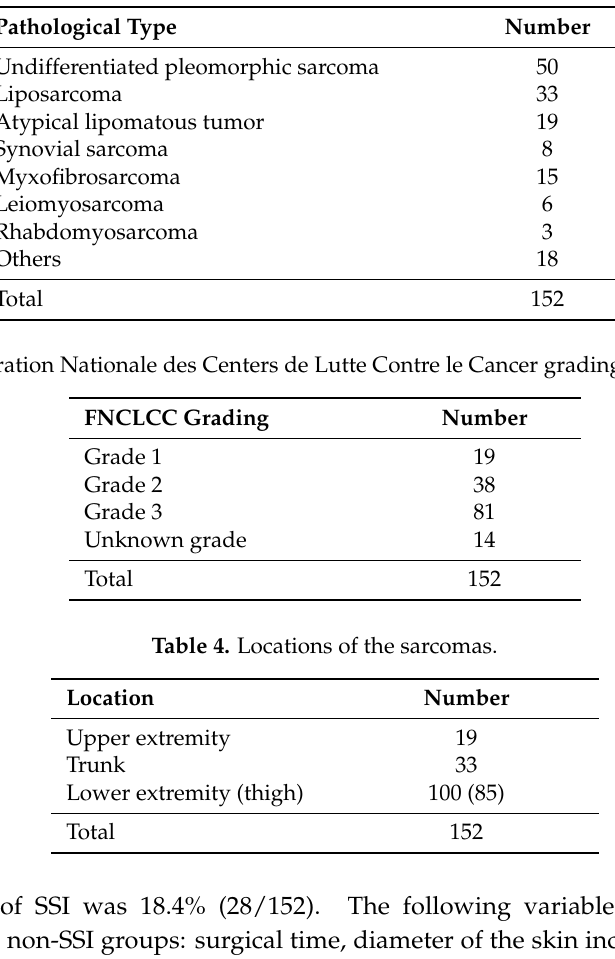
Table 2. Types of sarcomas.